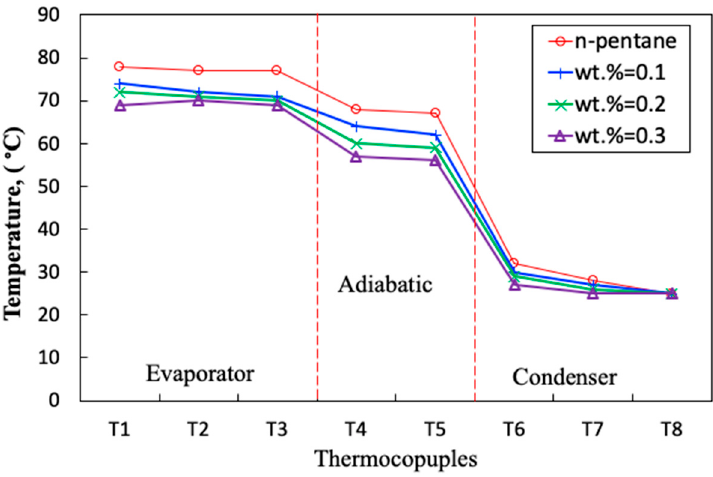
Figure 2. The temperature distribution of the HP for pentane and GNP-pentane nanofluids.